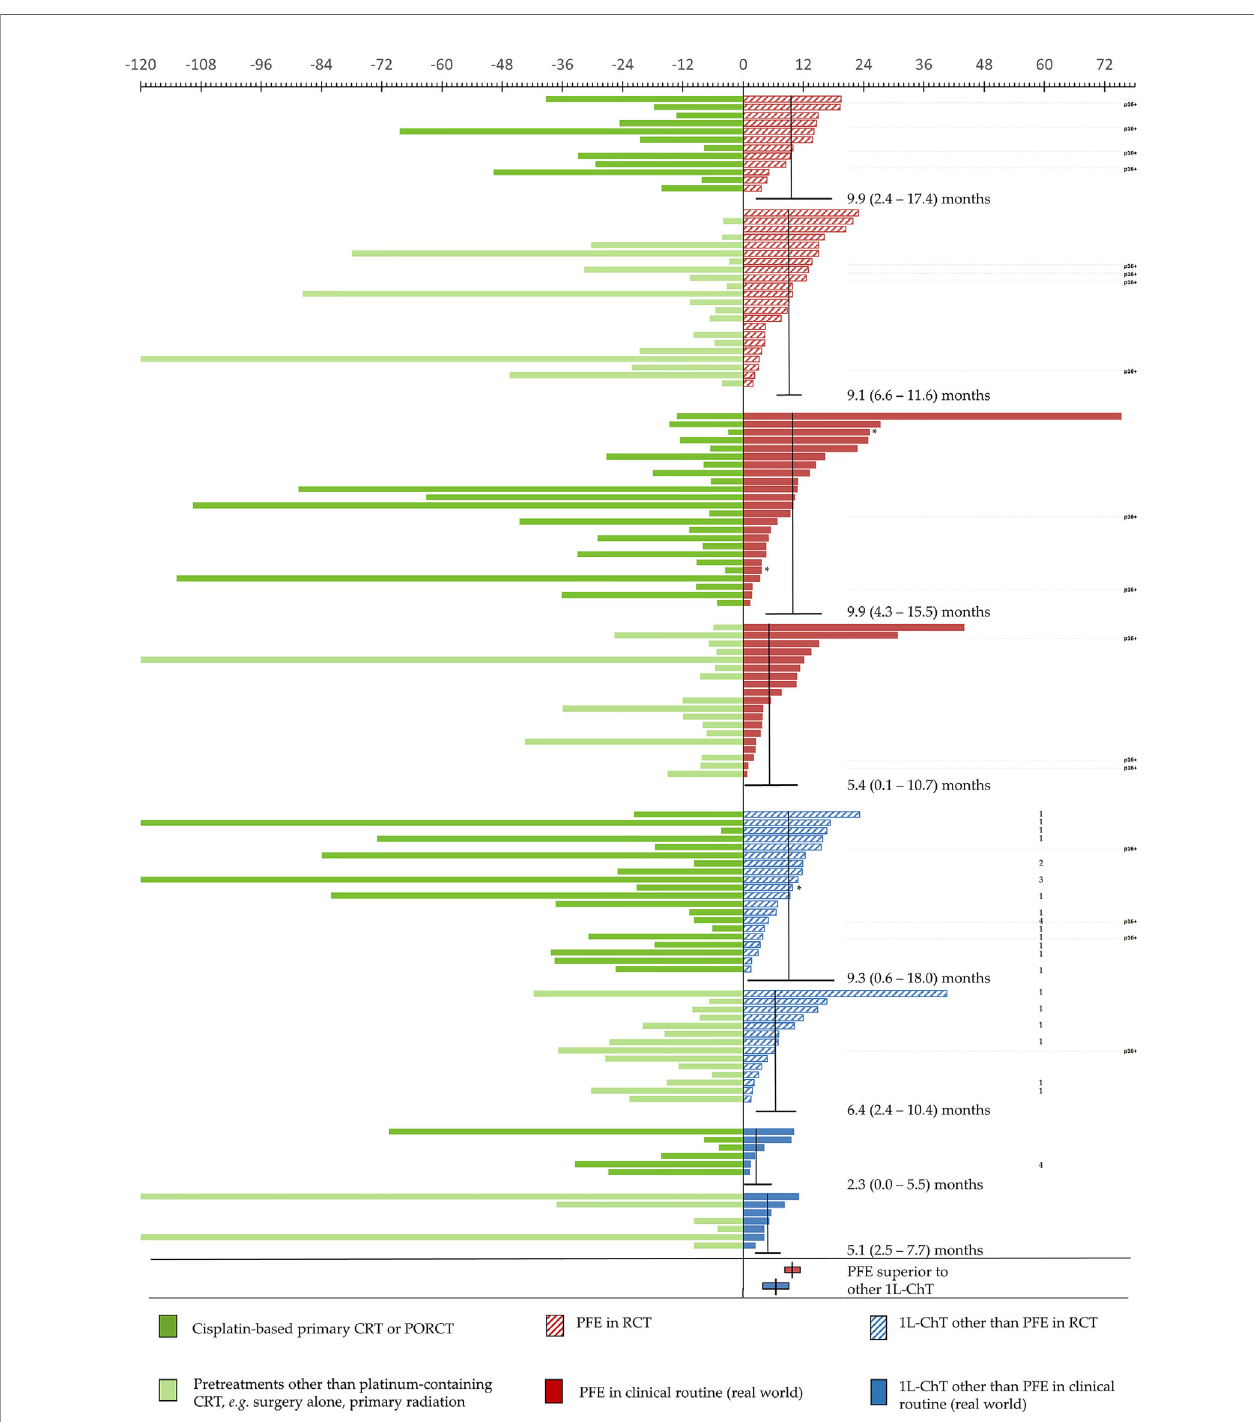
FIGURE 5 | Individual outcome of 124 patients with incurable recurrent/metastatic head and neck squamous cell carcinoma (R/M HNSCC) receiving various fi rst-line chemotherapy regimens are depicted according to overall survival measured from diagnosis of R/M HNSCC til death (OS 1L-ChT ). Patients are shown sorted strati fi ed according to 1L-ChT, either EXTREME-regimen (PFE, red; n = 77) or other 1L-ChT (blue; n = 47) and treatment either within randomized controlled trial (RCT; shaded) or in clinical routine ( “ real world setting ” , full). Type of prior treatment in curative attempt is indicated in dark green (cisplatin-based chemo-radiation (CRT) or post-operative radio-chemotherapy (PORCT)) vs . light green (other or no pretreatment); time from initial diagnosis of HNSCC until diagnosis of incurable disease requiring 1L-ChT is shown in the left panel, OS 1-ChT in the right panel according to the upper scale showing time in months. The horizontal lines indicate mOS 1-ChT (95% con fi dence interval). Median and 95%CI of OS 1l-ChT of PFE vs . other 1L-ChT in the total cohorts are shown in the lower rows. *censored: alive at last follow-up ( n = 3); 1, CeFCiD (6); 2, ADVANTAGE (7); 3 RESGEX (8); 4, TPExtreme (9); p16+, p16+